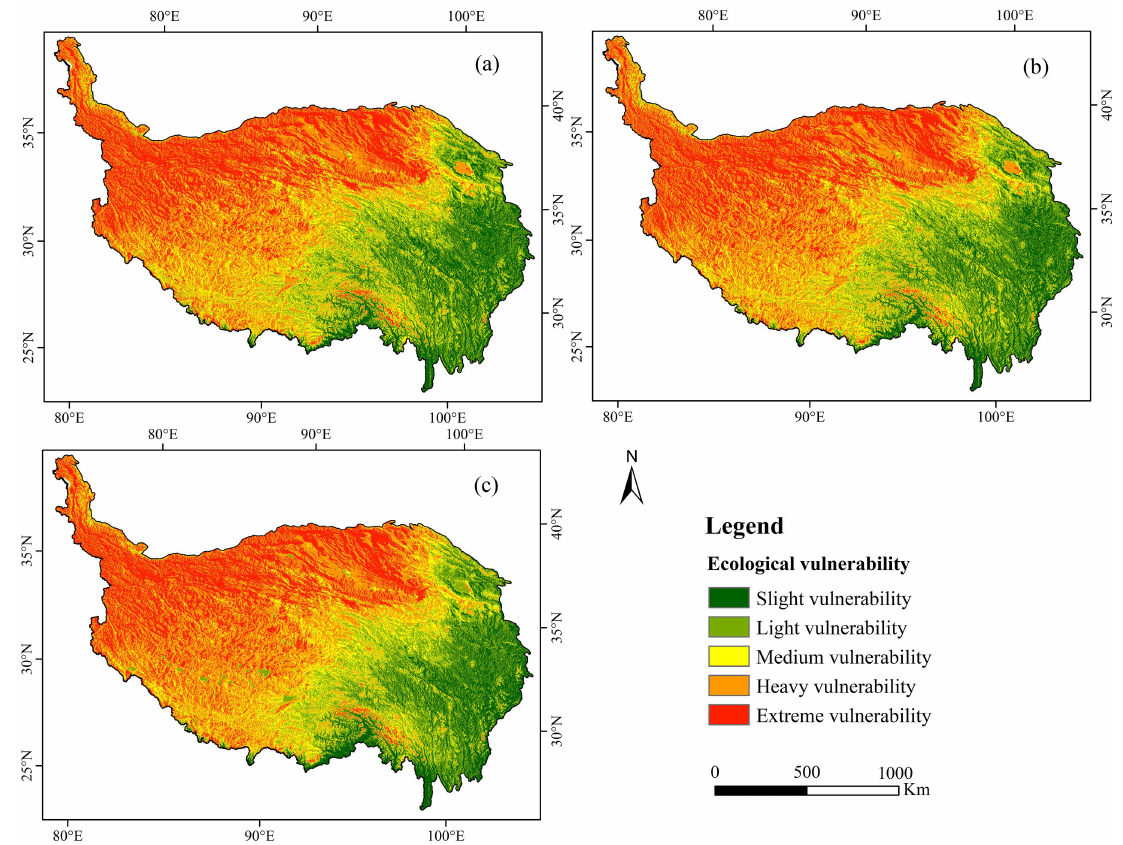
Figure 5. Spatial distribution of ecosystem vulnerability on the Qinghai-Tibet Plateau in ( a ) 2005, ( b ) 2010 and ( c )